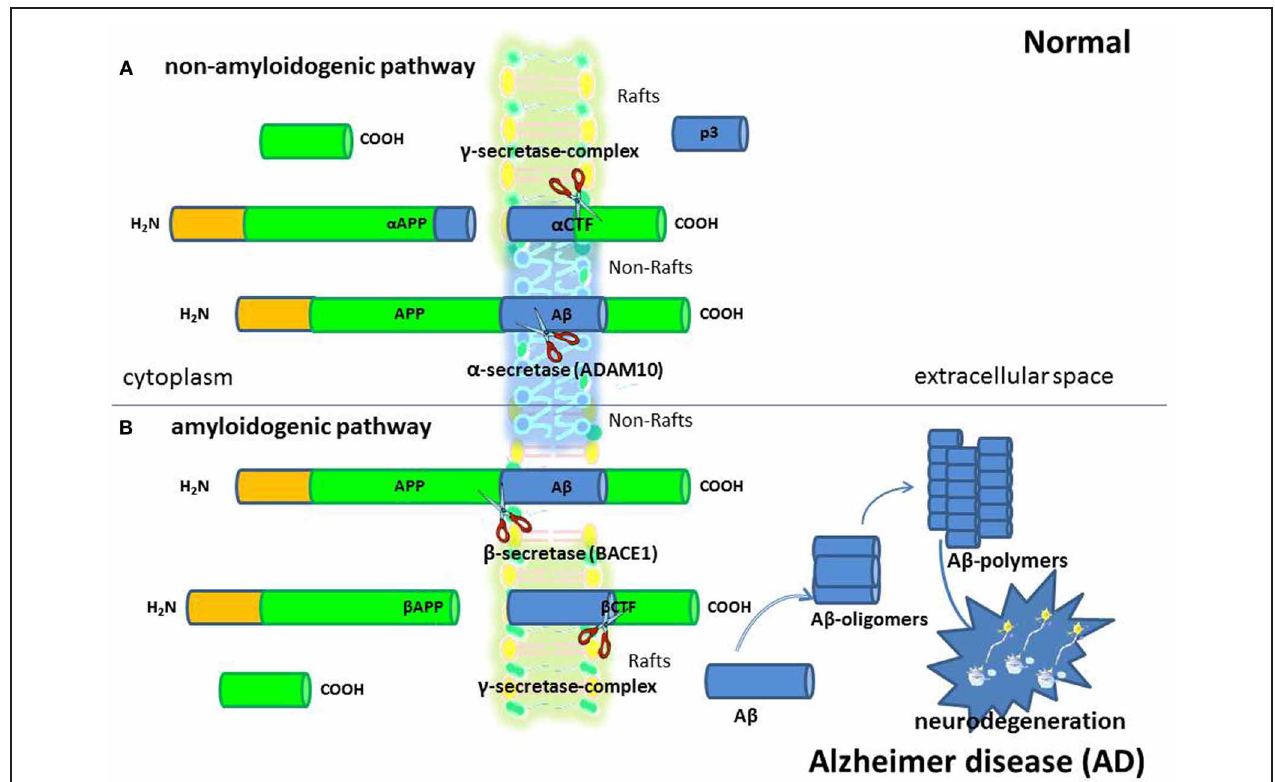
diagnose the disease in autopsy. A β peptides are fragments from a larger protein called amyloid precursor protein (APP), a transmembrane protein that penetrates through the neuron’s membrane. They are generated in the amyloidogenic pathway (B) of APP processing by sequential proteolysis by β - (BACE1) and γ -secretases. In the alternative non-amyloidogenic APP processing pathway (A) , α -secretase cleaves within the A β peptide region and prevents A β